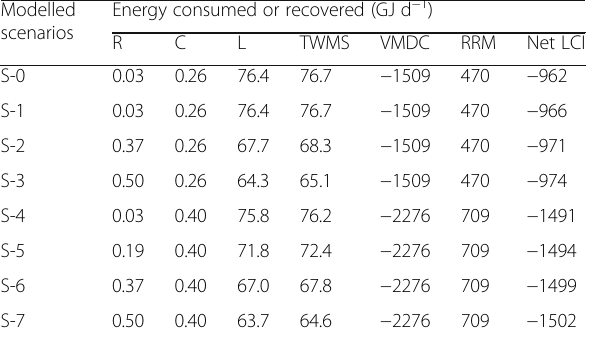
Table 10 Energy consumption in different modelled scenarios Modelled